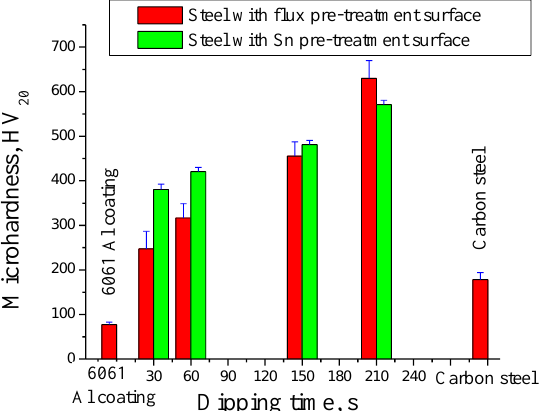
Figure 11. Interfacial hardness as a function of dipping time of steel — Al alloy coating for steel with flux and Sn pre-treatment surfaces.